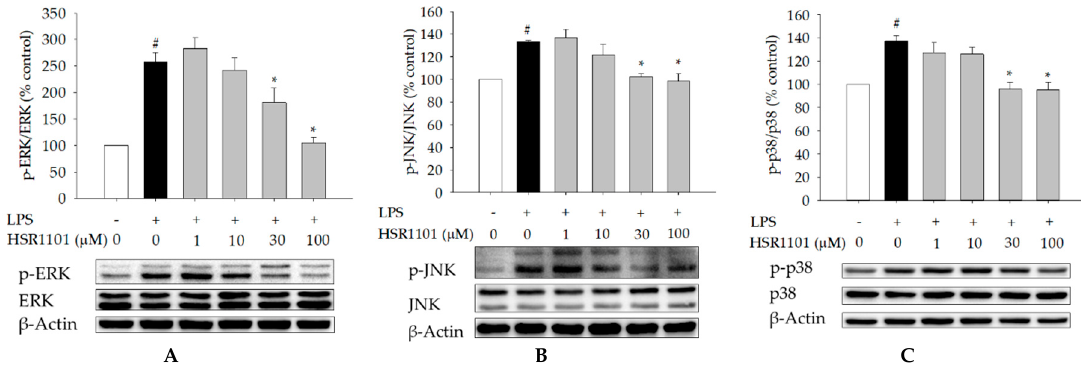
A B C Figure 7. HSR1101 inhibited LPS-induced phosphorylation of the MAPK family including ERK1/2, JNK, and p38 MAPK in BV2 cells. BV2 cells were co-treated with 1 µg/mL LPS and a series of concentrations of HSR1101 for 24 h. Western blotting analyses were conducted using anti-phospho- ERK1/2 and anti-ERK1/2 antibodies ( A ), anti-phospho-JNK and anti-JNK antibodies ( B ), anti- phospho-p38 MAPK and anti-p38 MAPK antibodies ( C ), as described in the Materials and methods section. β -Actin was used for normalizing phospho-ERK1/2, phospho-JNK, and phospho-p38 MAPK. Representative blots are displayed. Data are expressed as mean ± SEM of at least three independent experiments. # p < 0.05 and * p < 0.05 vs the vehicle-treated control and LPS-treated groups, respectively. LPS, lipopolysaccharide; MAPK, mitogen-activated protein kinase; ERK1/2, extracellular signal-regulated kinase 1/2; JNK, c-Jun N-terminal kinase.